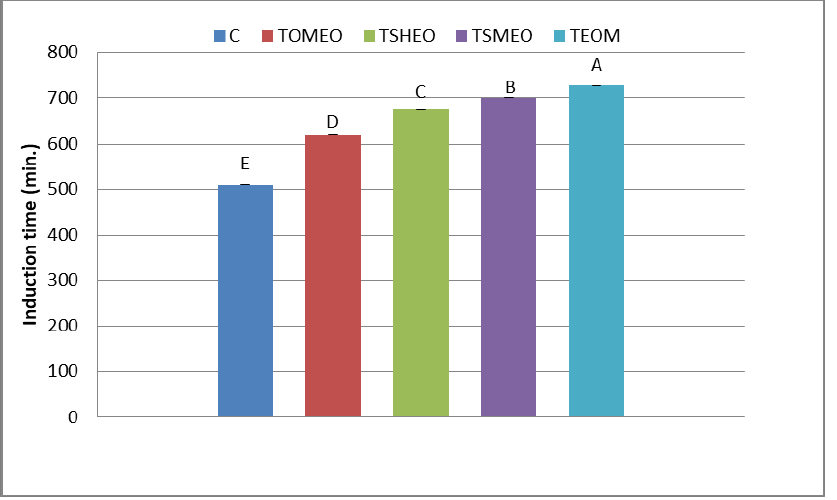
Figure 1. Oxidative stability of fresh turkey sausages. TOMEO — 0.150 µL/g O. majorana essential oil; TSHEO — 0.150 µL/g S. hortensis essential oil; TSMEO — 0.150 µL/g S. montana essential oil; TEOM — 0.050 µL/g O. majorana essential oil; 0.050 µL/g S. hortensis essential oil; and 0.050 µL/g S. montana essential oil. Control (C). Different upper cases in superscripts (A – E) indicate difference ( p < 0.05) between treatments.